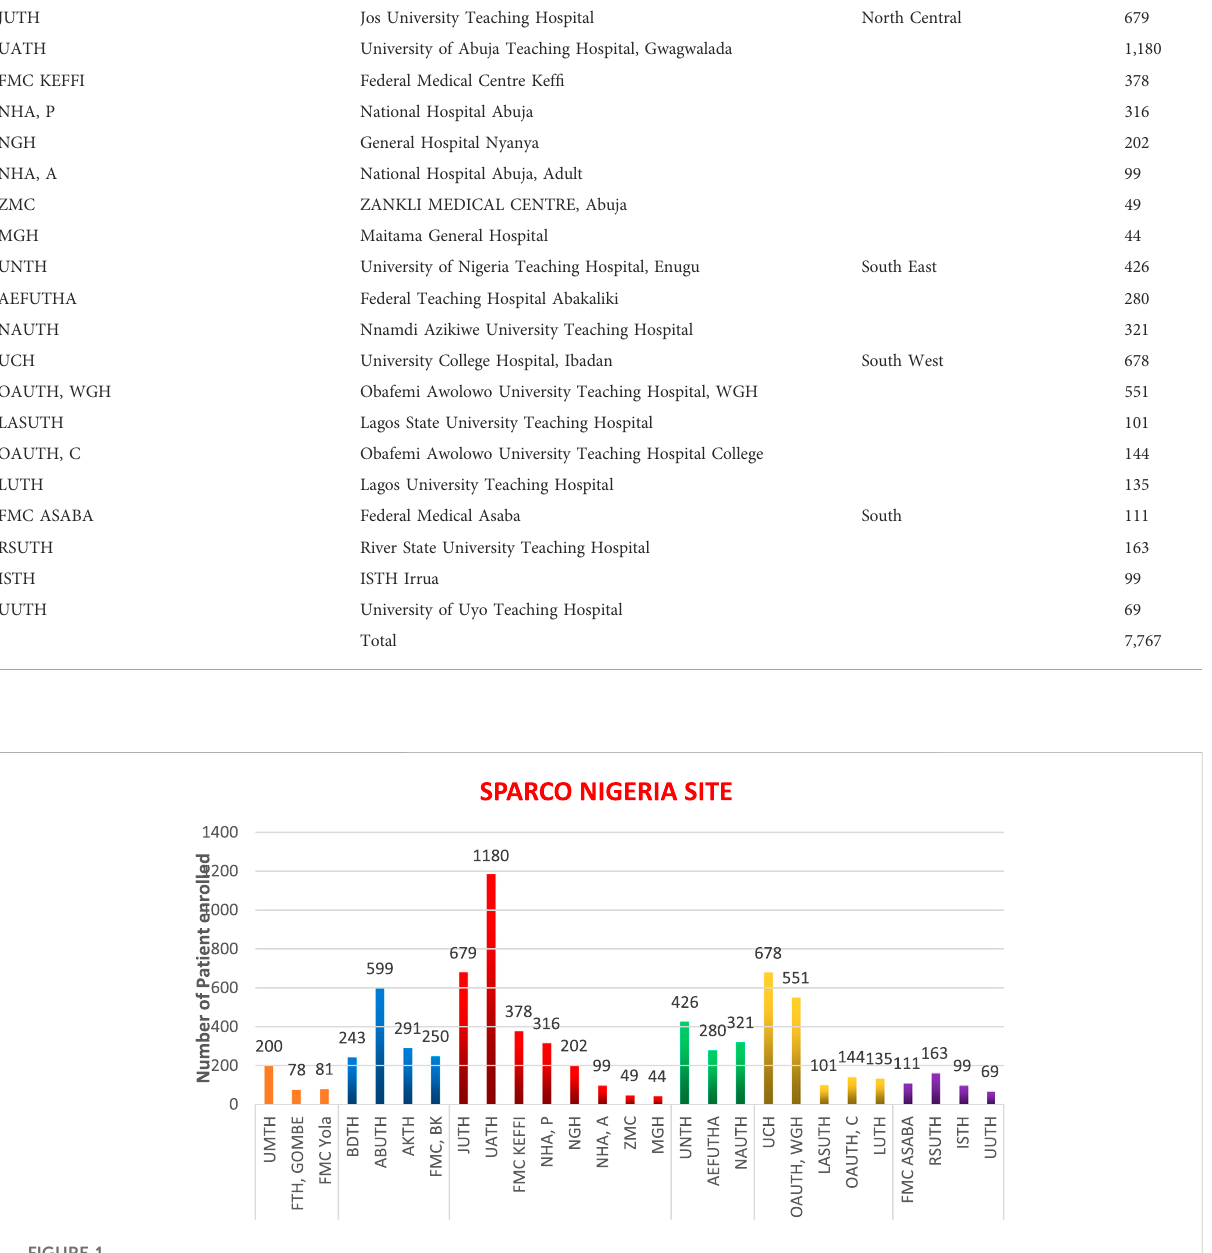
FIGURE 1 Enrolment by SPARCO Nigeria